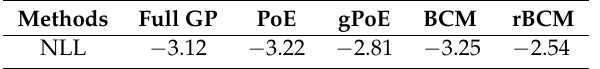
Table 3. NLL comparison of four fusion methods with full Gaussian process